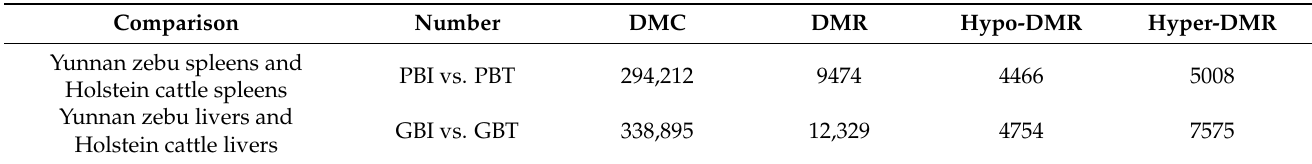
Table 2. Differentially methylated cytosine (DMC) and differential methylated regions (DMR) in the two